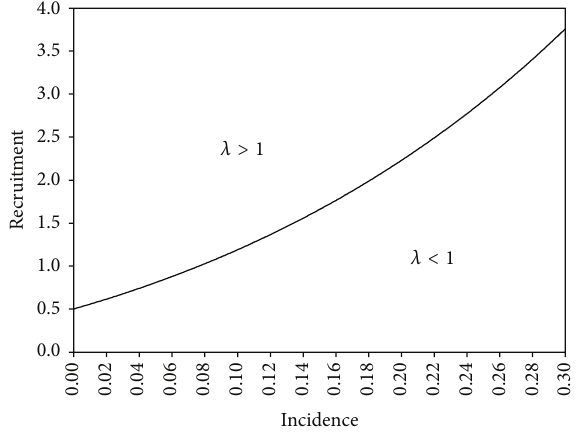
Figure 4: Annual number of Gorgonia ventalina recruits that a locality needs to receive (per standing adult) to maintain population equilibrium ( 𝜆 = 1 ) as a function of disease incidence. Localities above the equilibrium threshold will exhibit population growth ( 𝜆 > 1 ), and those below it will decline ( 𝜆 < 1